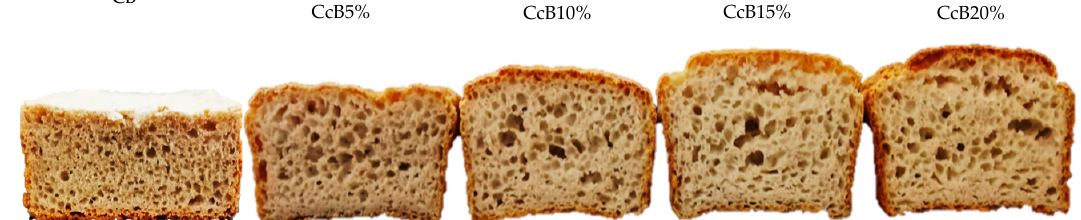
Figure 4. Comparation of the resulted breads obtained for control bread (CB) and those breads obtained by different additions of curd cheese (CcB): CcB5% up to CcB20% .